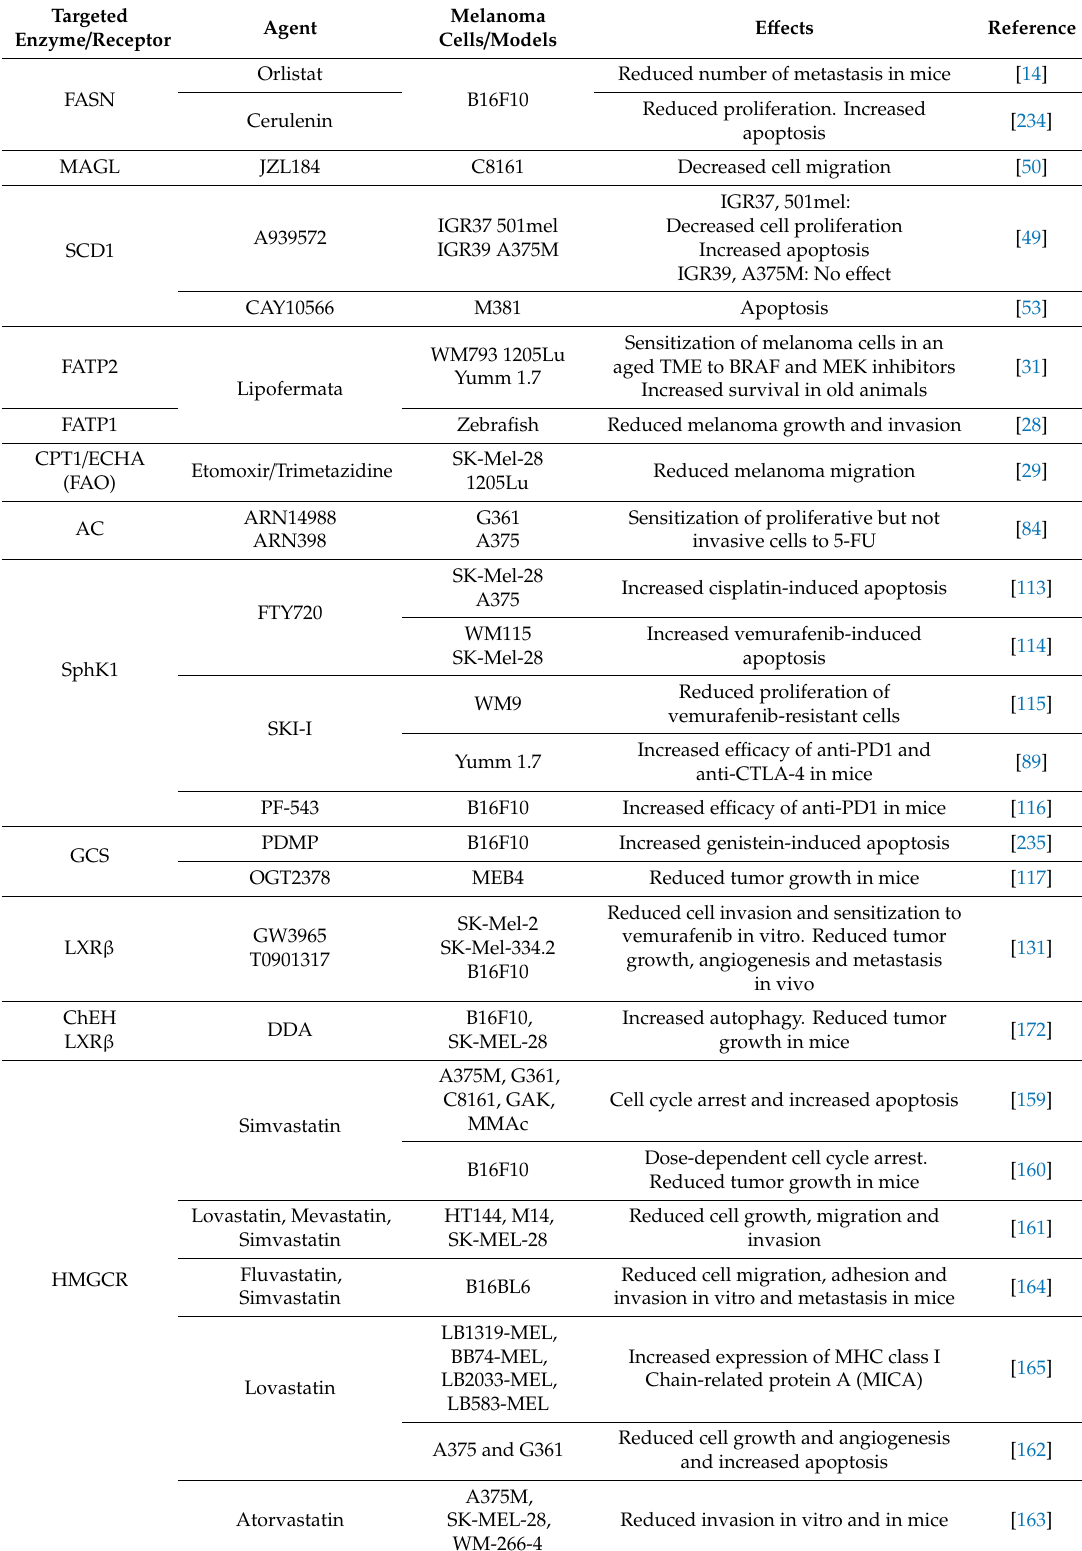
Table 2. E ff ects of pharmacological agents targeting lipid metabolism in